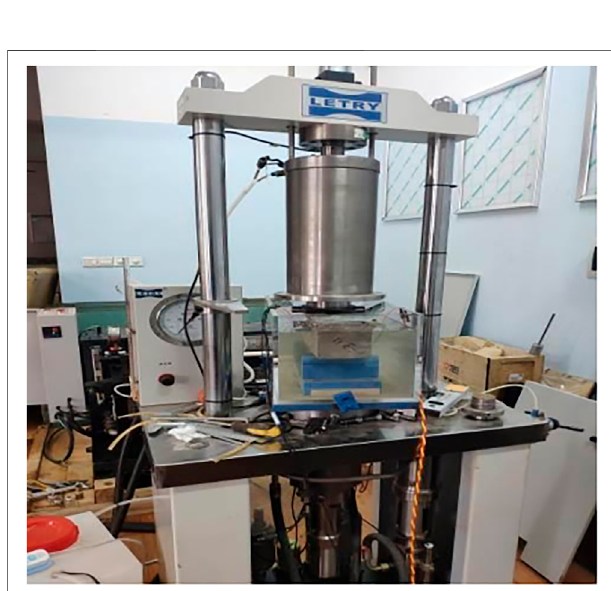
FIGURE 5 | Loading device (SDT-50).